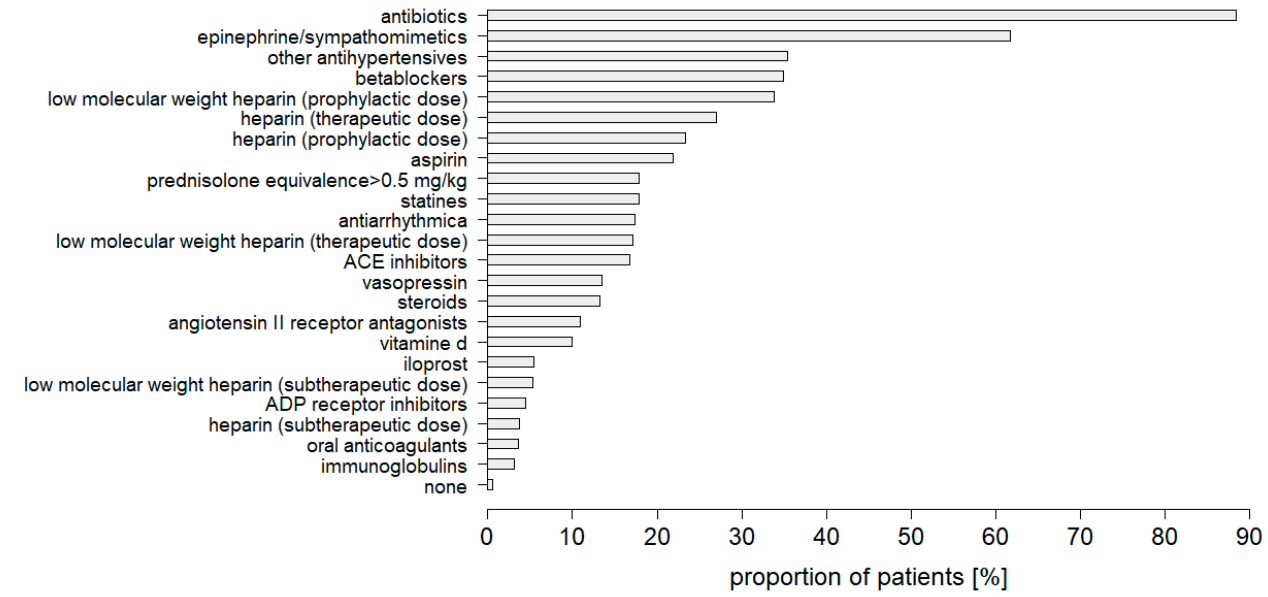
Figure 5. Medication used in intensive care for patients critically ill with COVID-19.